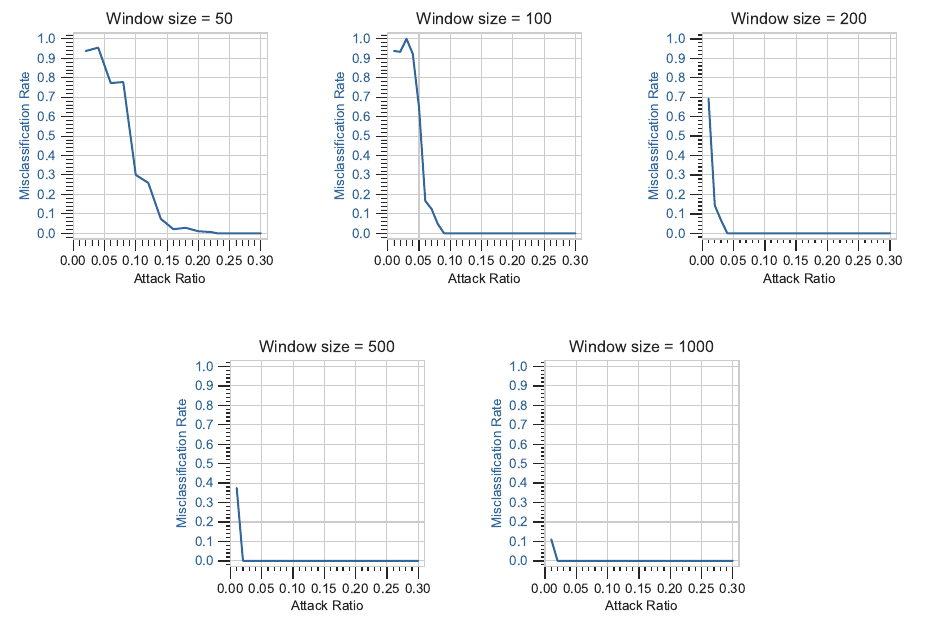
Figure 8. Attack ratio vs. misclassification rate for different window sizes (Fuzzy attack).